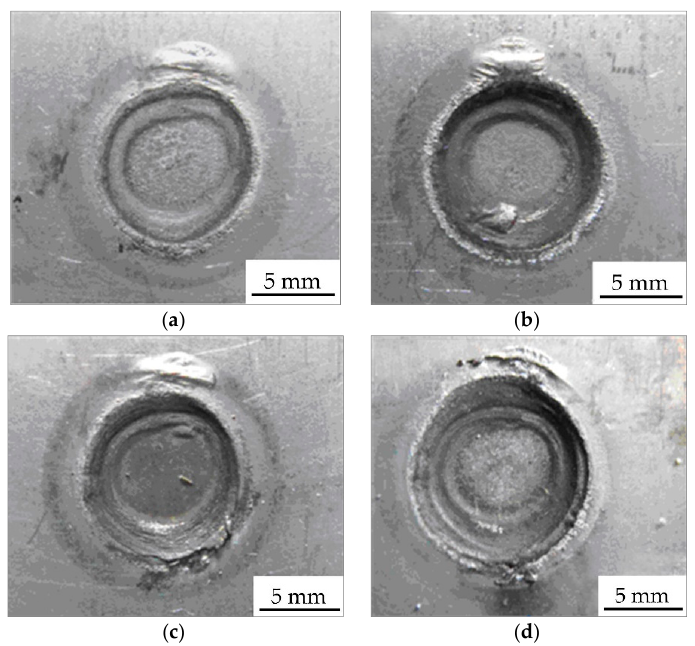
Figure 3. Resistance spot weld appearance gained with different welding currents: ( a ) 8.5 kA; ( b ) 10.0 kA; ( c ) 11.0 kA; ( d ) 12.0 kA.